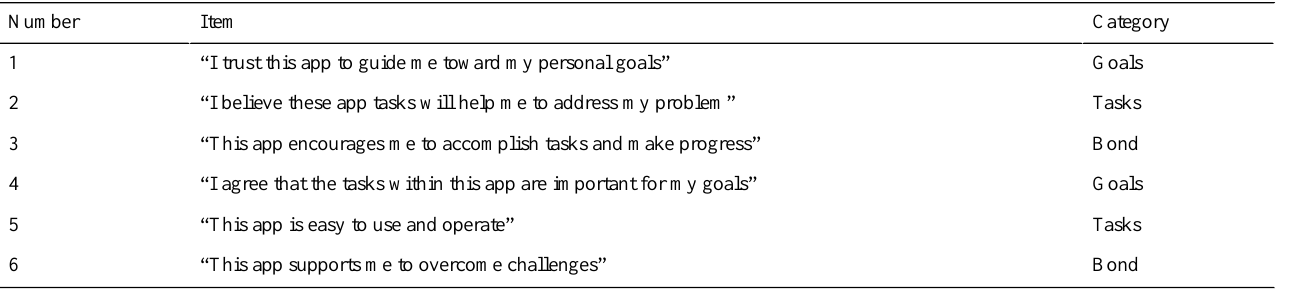
Table 1. Items of the Digital Working Alliance Inventory.